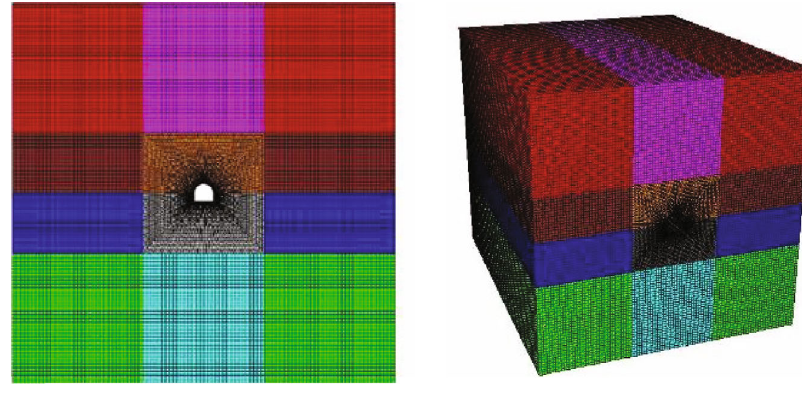
Figure 11: Numerical simulation